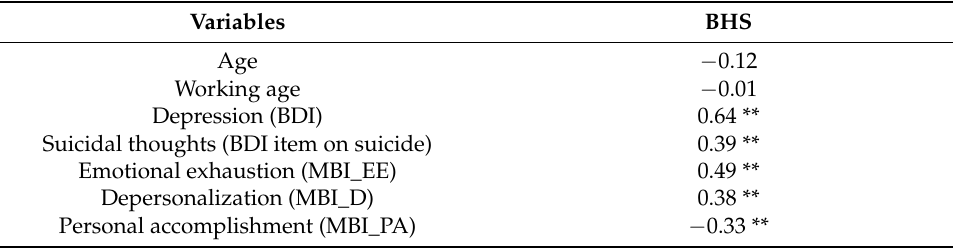
Table 3. Correlations of hopelessness with age, working age, depression, suicidal thoughts, and burnout